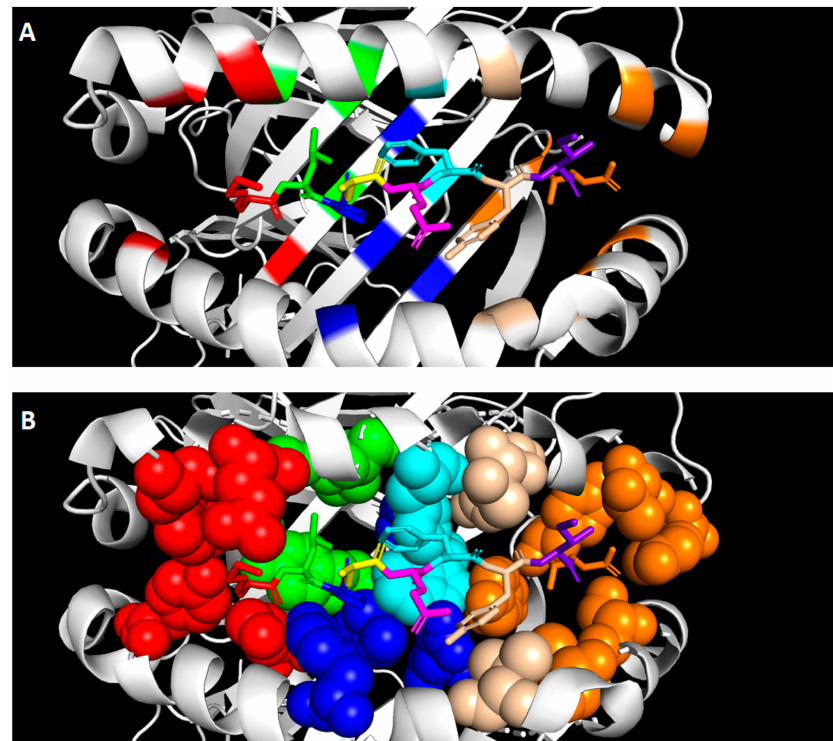
Figure2. PrimarystructureandpresentationofpeptidespresentedbyHLA-G1.Thepeptideispositionedin the peptide binding groove of HLA-G formed by two alpha helices and a beta sheet floor. Each position of the peptide with its corresponding binding pocket is visualized by di ff erent colors: position 1 and binding pocket A in red, position 2 and binding pocket B in green, position 3 and binding pocket D in blue, position 4 in yellow, position 5 in pink, position 6 and binding pocket C in cyan, position 7 and binding pocket E in beige, position 8 in purple, and position 9 and binding pocket F in orange. ( A ) The secondary structure of the binding groove is depicted with the peptide in the center. ( B ) The binding pockets are depicted as spheres to visualize the spacious structure of the pocket. The crystal structure was obtained from Walpole et al. [35] and modified with PyMOL (v. 2.4.0). Abbreviations: human leukocyte antigen G1